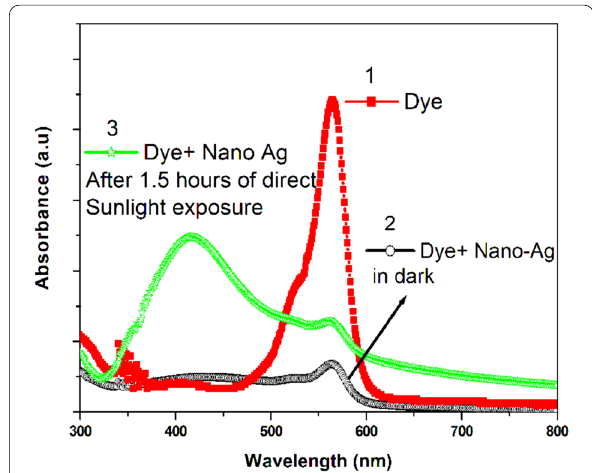
Fig. 10 Optical absorbance of (1) 1 µM/L sulforhodamine B dye aqueous solution, (2) mixture of sample 1S5 and 1 µM/L sulforhodamine B dye aqueous solution immediately after mixing and (3) mixture of sample 1S5 and 1 µM/L sulforhodamine B dye aqueous solution after direct solar light irradiation for 1.5 h